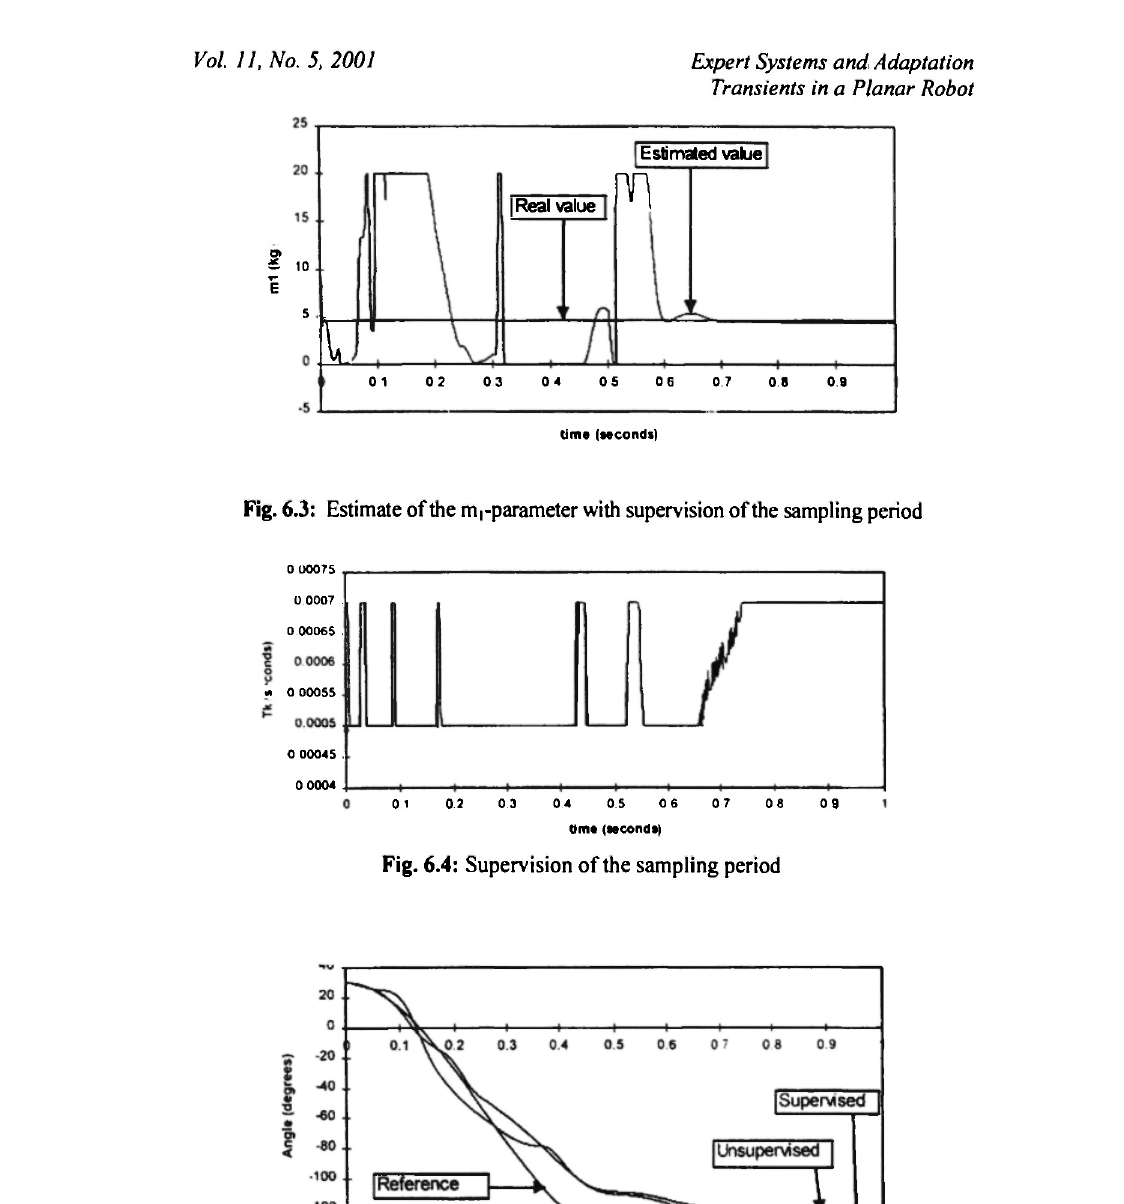
Fig. 7.1: Position of the second joint with supervision ofc^and T k and without supervision